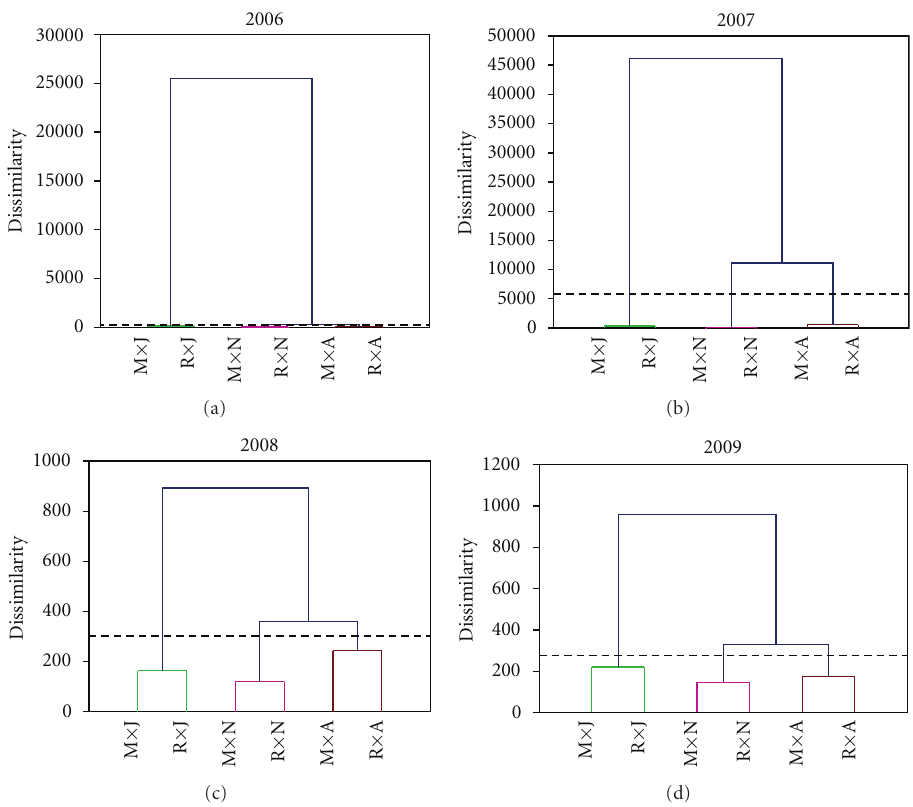
Figure 2: Results of cluster analyses conducted on the ecosystem profiles of the soils, comprising both physicochemical and biological variables, obtained for each year of the study (M = monoculture and R = rotation, J = June, A = August, and N =